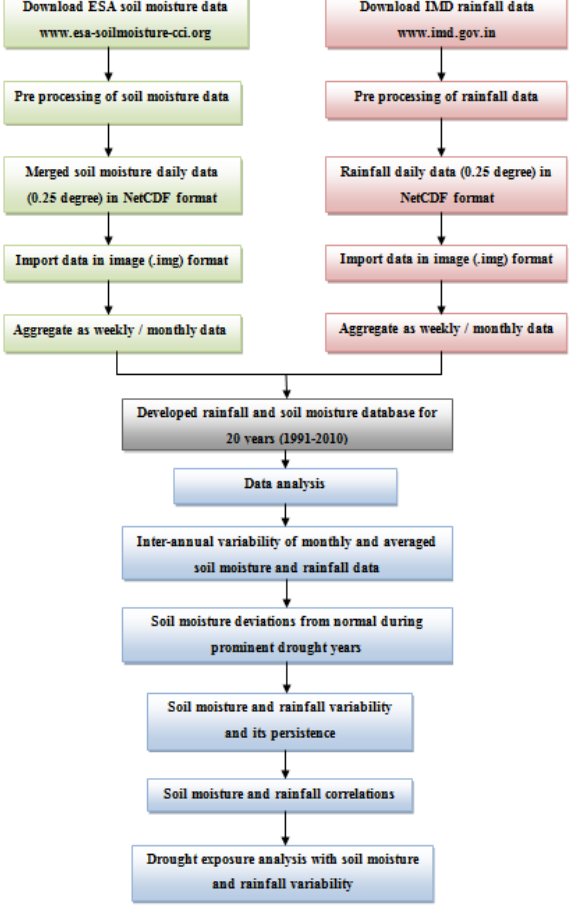
Figure 1: The flowchart depicting the overall